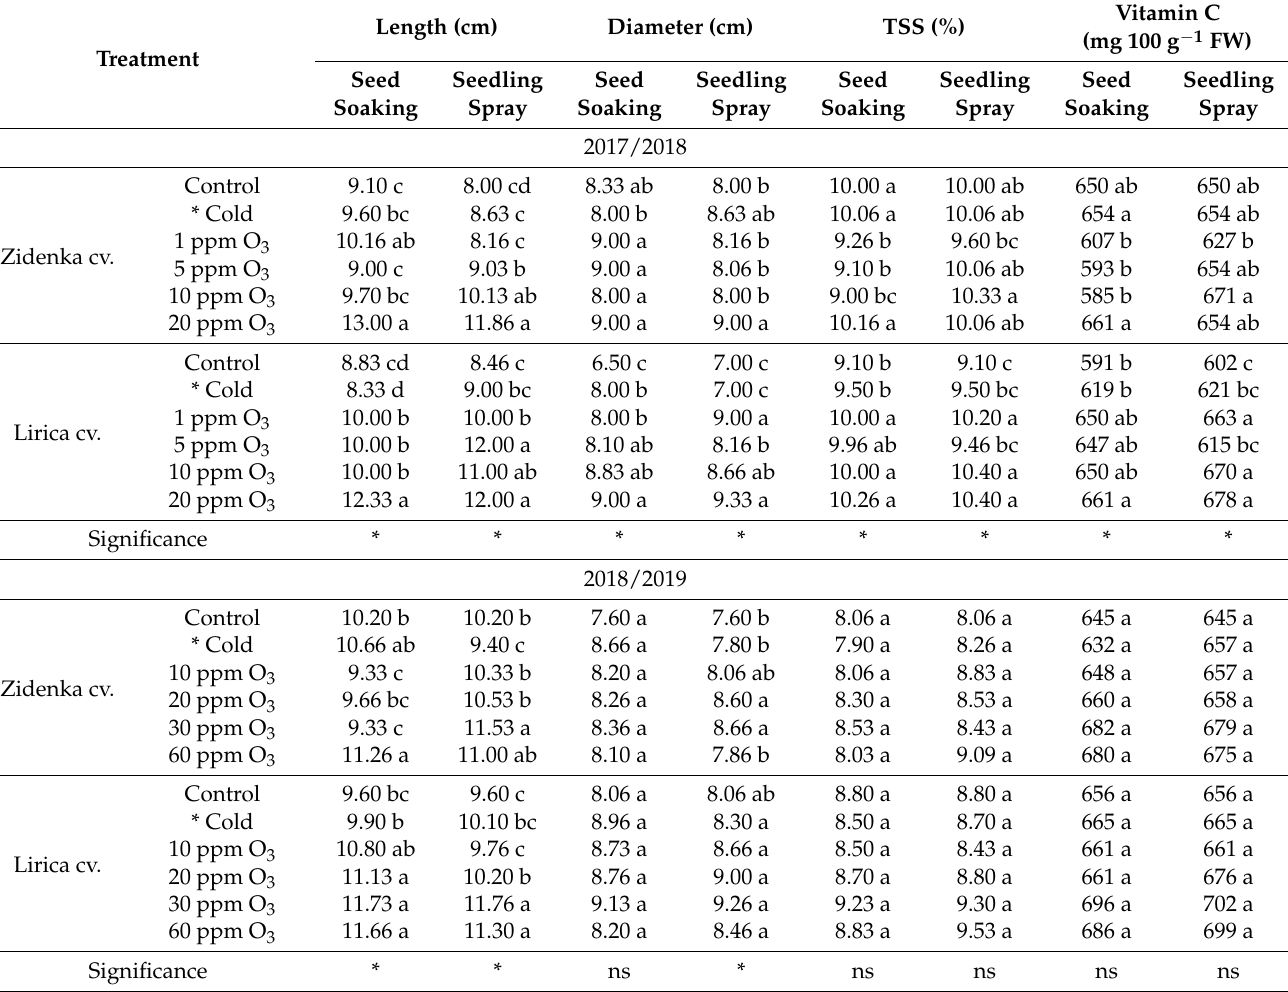
Table 7. Effect of ozone and chilling tolerance pretreatments on morphological and chemical quality characteristics of the fruits of two sweet pepper hybrids during the 2017/18 and 2018/19 seasons.